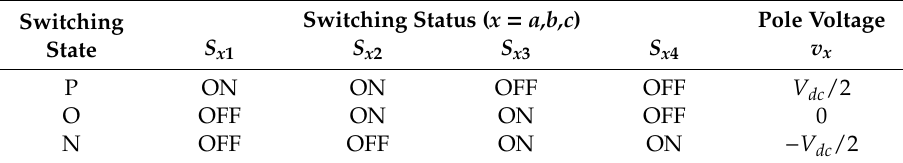
Table 1. States and pole voltage of NP rectifier depending on switch